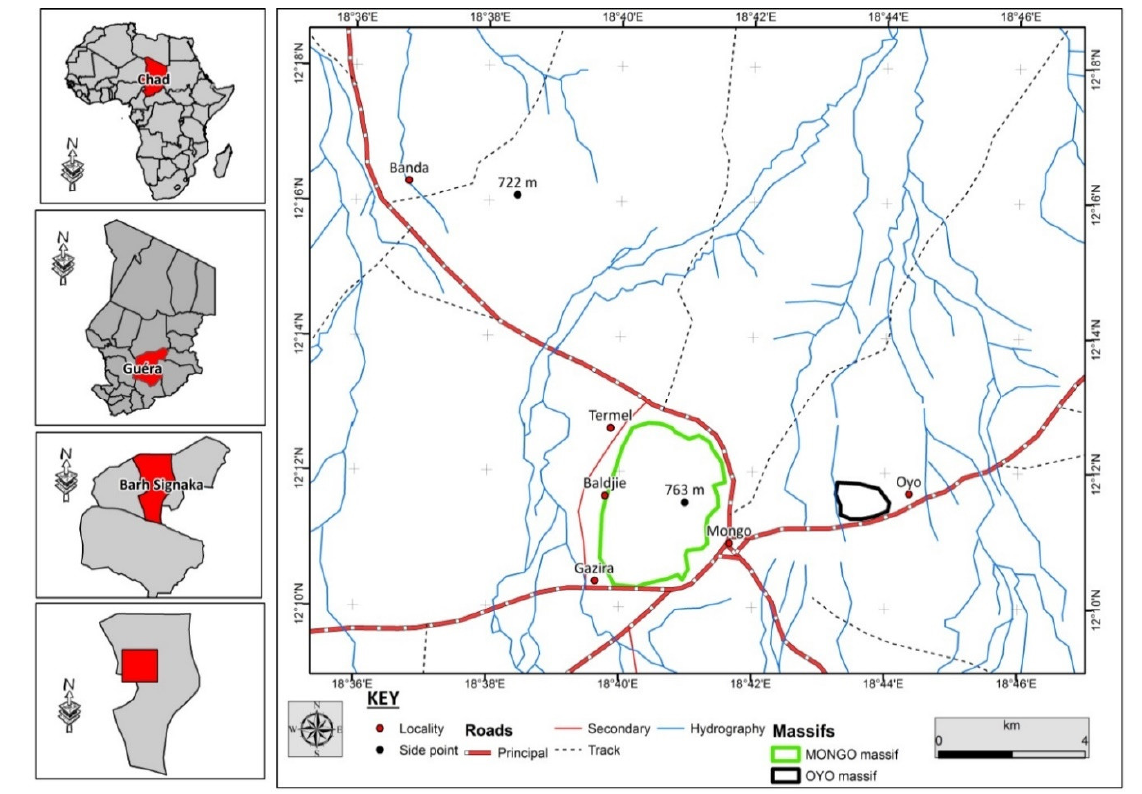
Figure 1. Detailed location map of the study area, with general location at different scales on the left.